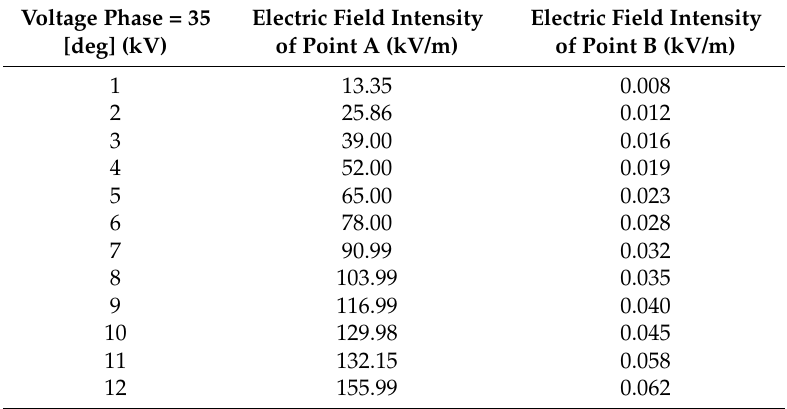
Table 4. Electric field intensity at A and B when sensor is introduced.